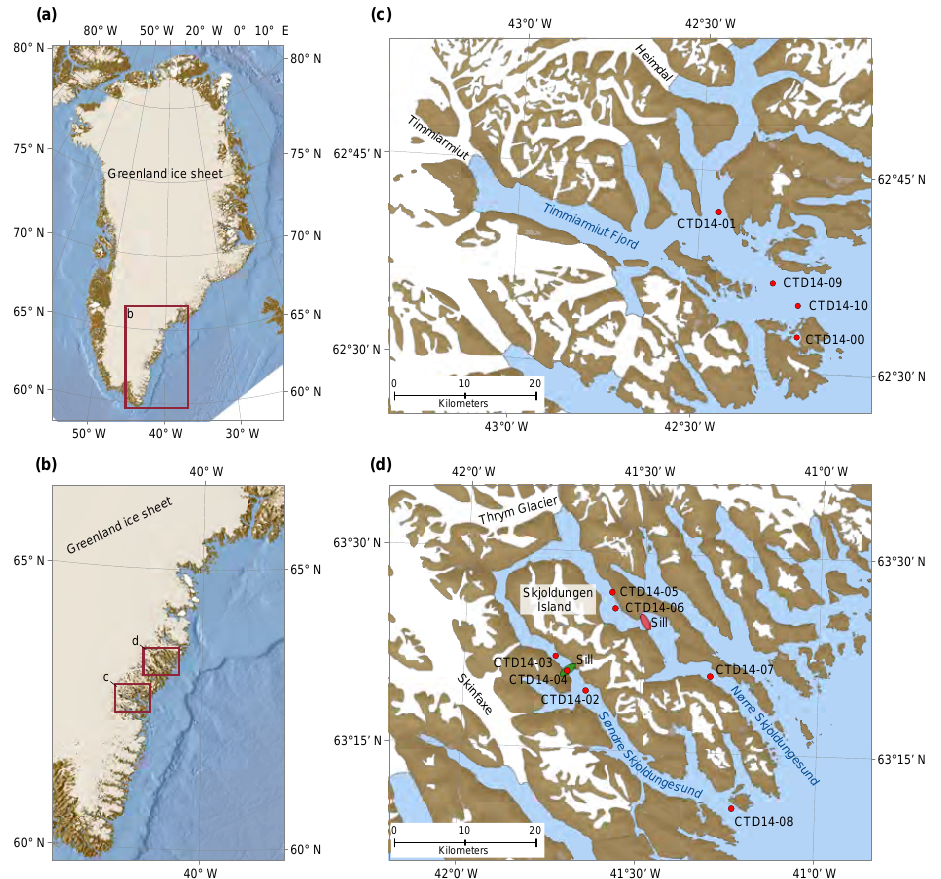
Figure 2. Maps of Greenland (a) and the southeast coast (b) with red boxes show location of the study sites. Map of the Timmiarmiut Fjord system (c) and the fjord complex around Skjoldungen (b) with Nørre Skjoldungesund (NSsund) towards the north and Søndre Skjoldunge- sund (SSsund) towards the south (d) . Note the location of two sills found in NSsund and SSsund. Also shown in (c–d) are the locations of the CTD